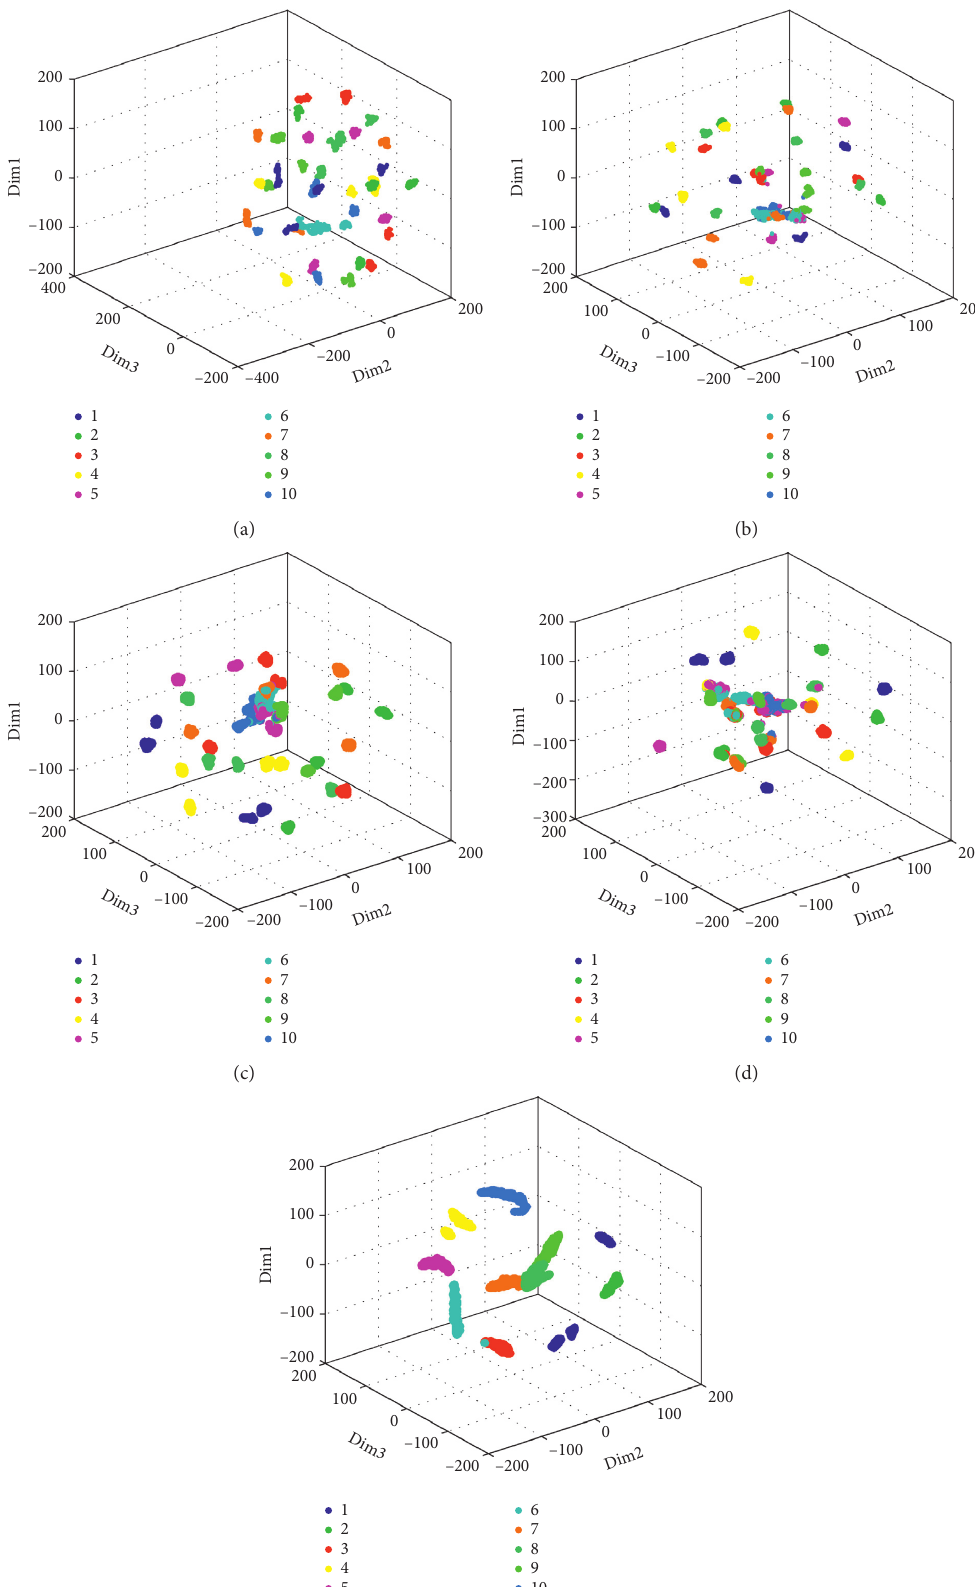
Figure 4: t-SNE results of output in different levels for bearing testing samples: (a) input level; (b) first hidden level; (c) second hidden level; (d) third hidden level; (e) output